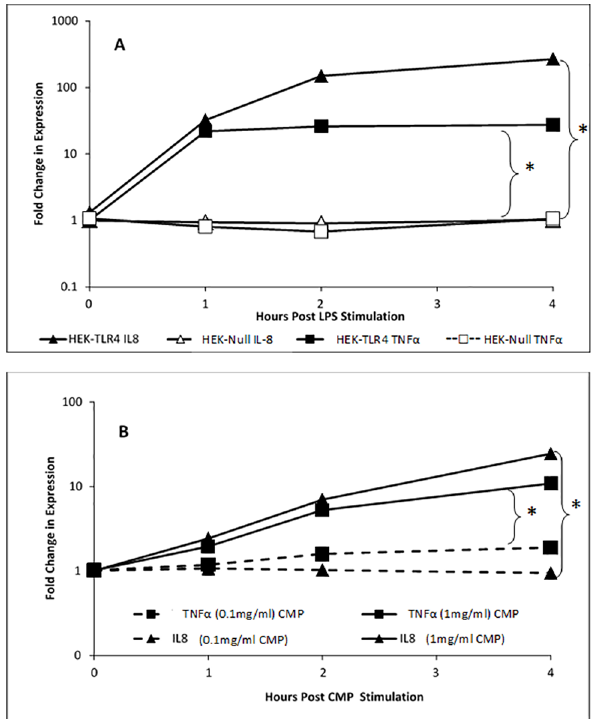
Fig 4. CMP-induced TLR4-signaling activates TNF α and IL-8 mRNA expression. TNF α (squares) and IL- 8 (triangles)transcript levels were assessedby quantitative PCR. (A) HEK-TLR4 reporter cells (filled symbols) and HEK-Nullreporter cells (open symbols) cells were stimulatedwith 12.5 ng/mL LPS for the indicatedtimes prior to RNA isolationand qPCR analyses. (B) HEK-TLR4 reporter cells were treated with different doses of CMP (1 mg/mL, solid line; 100 μ g/mL, dashed line) for the indicatedtimes (0–4 h). Significanceis represented by the asterisk, p (cid:20)